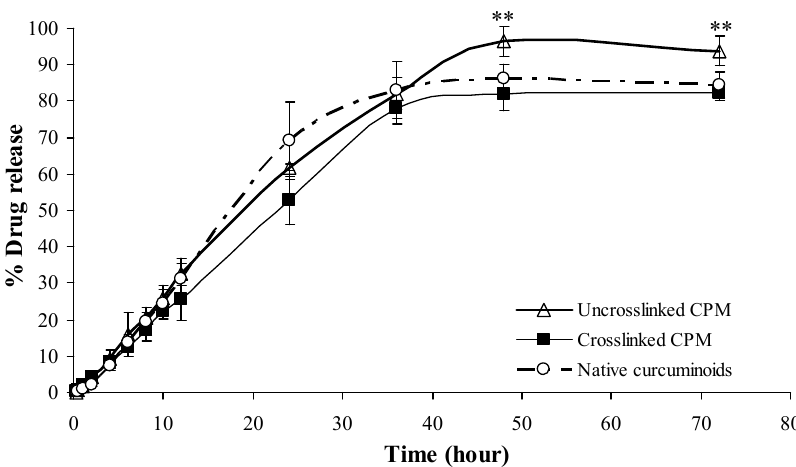
Figure 8. Release profiles of free curcuminoids, cross-linked and non-cross-linked curcuminoids microcapsules (CPM). Mean ± SD, n = 3. ** indicates p < 0.01 as compared with native curcuminoids group.